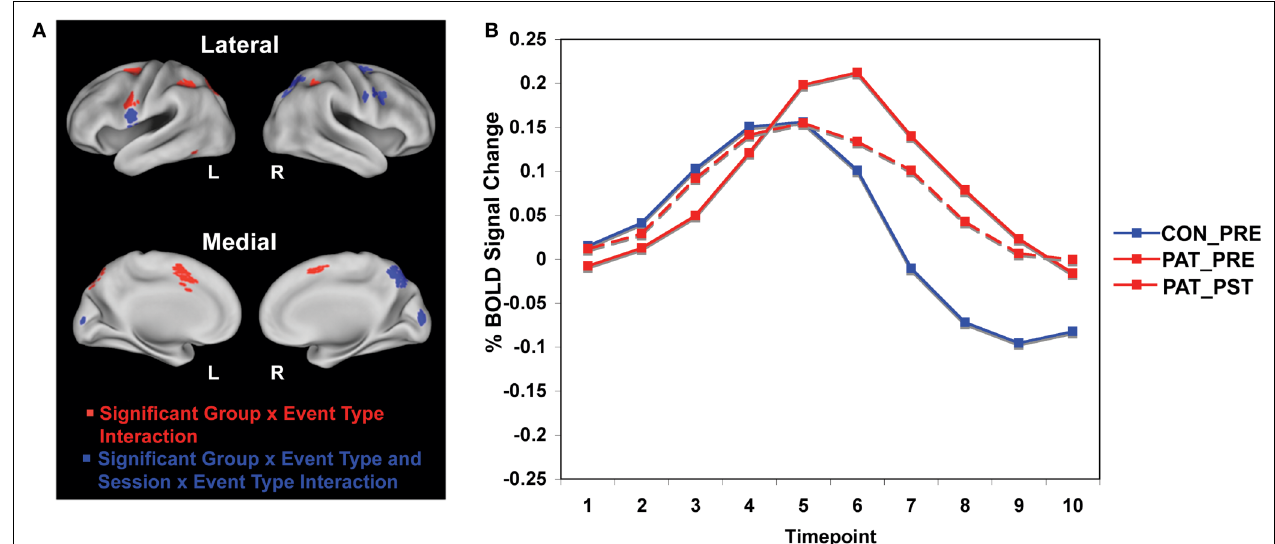
FIGURE 1 | (A) Brain regions showing group × event type interactions in patients and healthy controls and session × event type interactions in patients. Regions in red refl ect greater blood oxygen level-dependent (BOLD) response at cue in controls relative to patients prior to training, and regions in blue refl